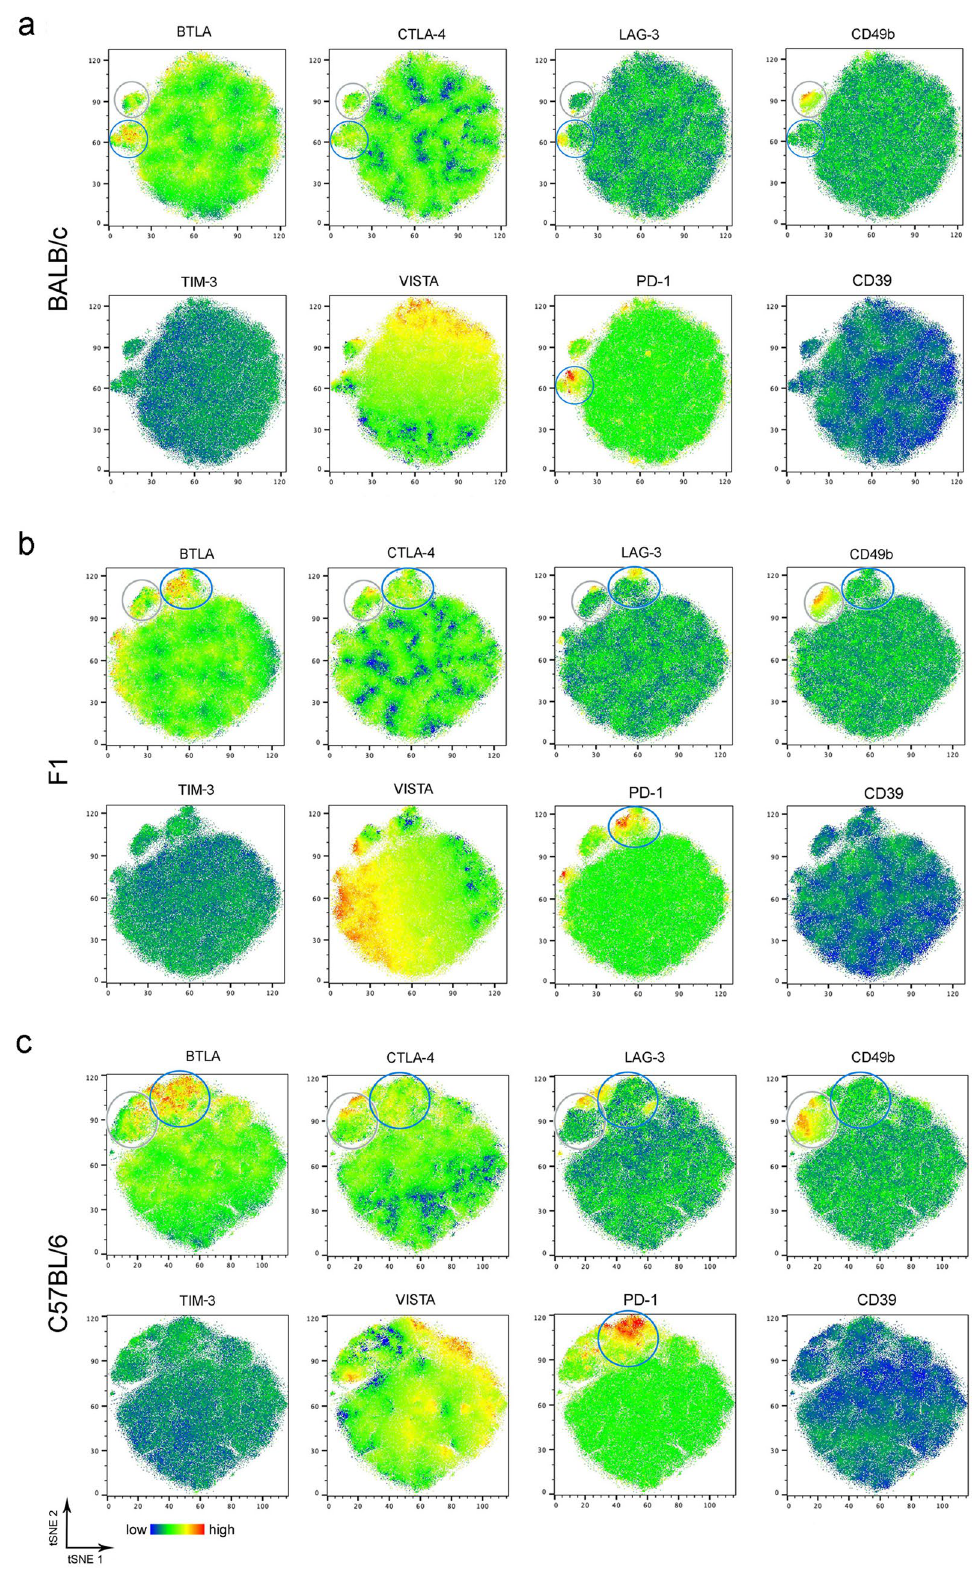
Figure 5. Expression of regulatory receptors is more pronounced by Foxp3 − CD4 + T cells from C57BL/6 mice than BALB/c and F1 mice. BALB/c, F1 and C57BL/6 mice were infected with 2000 iL3. Six days later mes LN were isolated and stained with a panel for regulatory receptors. t-SNE calculation was performed with 80,000 Foxp3 − CD4 + T cells using FlowJo Plugins. Representative t-SNE heatmaps derived from BALB/c ( a ), F1 ( b ) and C57BL/6 ( c ) showing the expression of BTLA, CTLA-4, LAG-3, CD49b, TIM-3, VISTA, PD-1 and